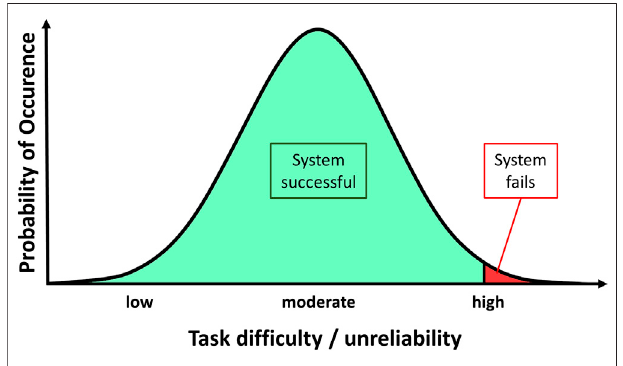
FIGURE 1 | General paradigm of the development of